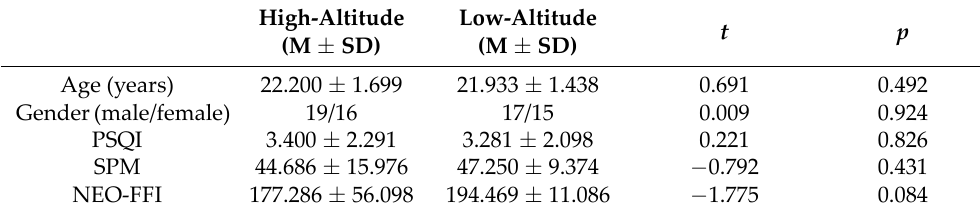
Table 2. Demographic data in high‑altitude and low‑altitude